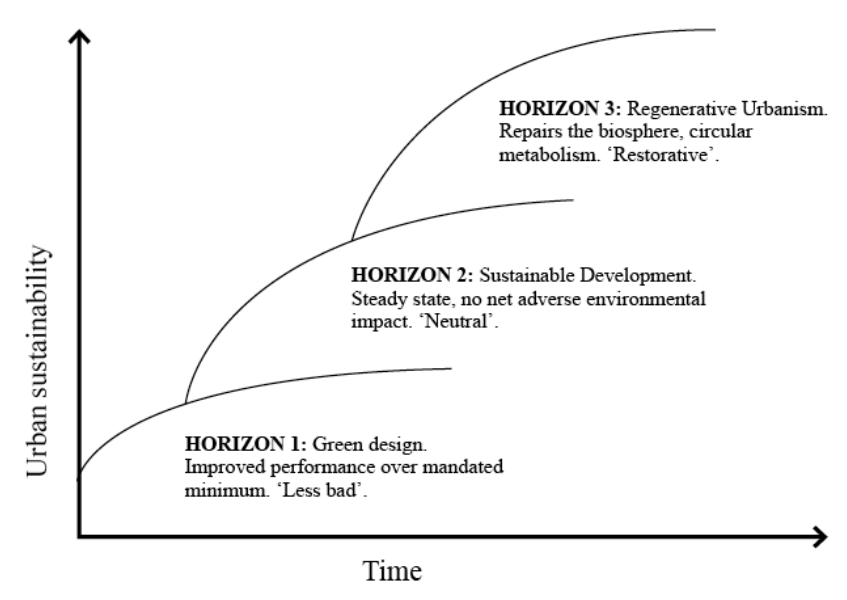
Figure 2. The three horizons of green urbanism.